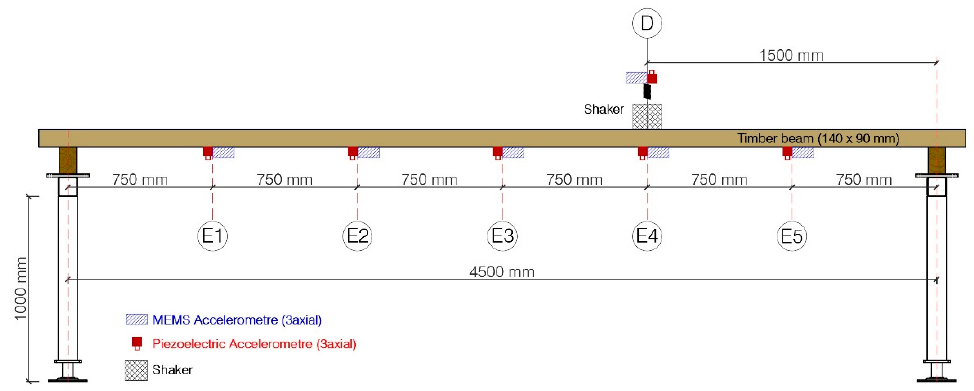
Figure 6. Elevation view of the measurement layout for the validation tests.